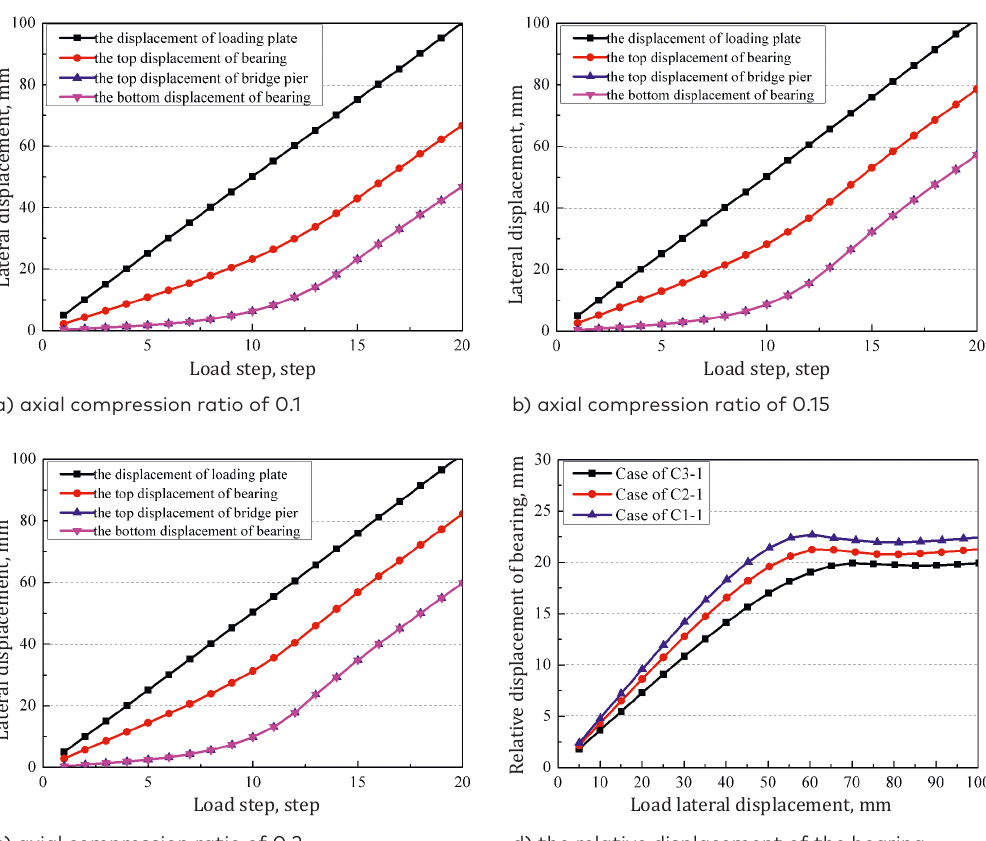
Figure 6. Lateral displacement of the series system with friction coefficient of 0.2 at the upper ends of the bearing